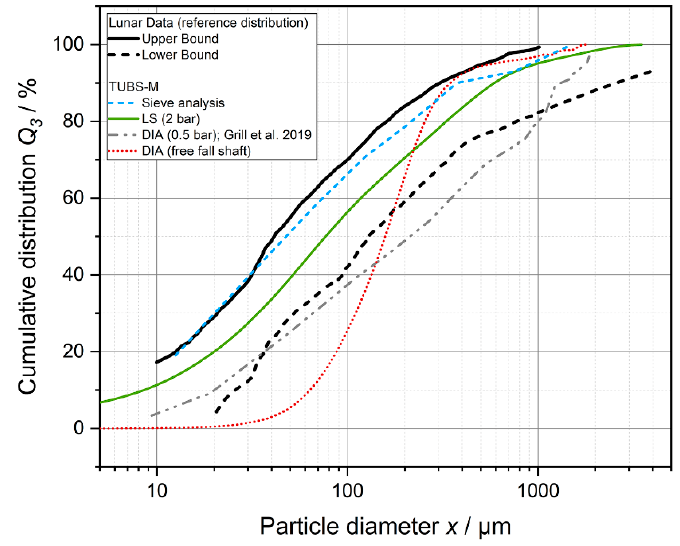
Figure 3. Cumulative particle size distributions of TUBS-M determined with different methods and from different authors (also Grill et al. [81]) compared to literature reference data of real lunar regolith [76]. Particle diameter equals particle size.